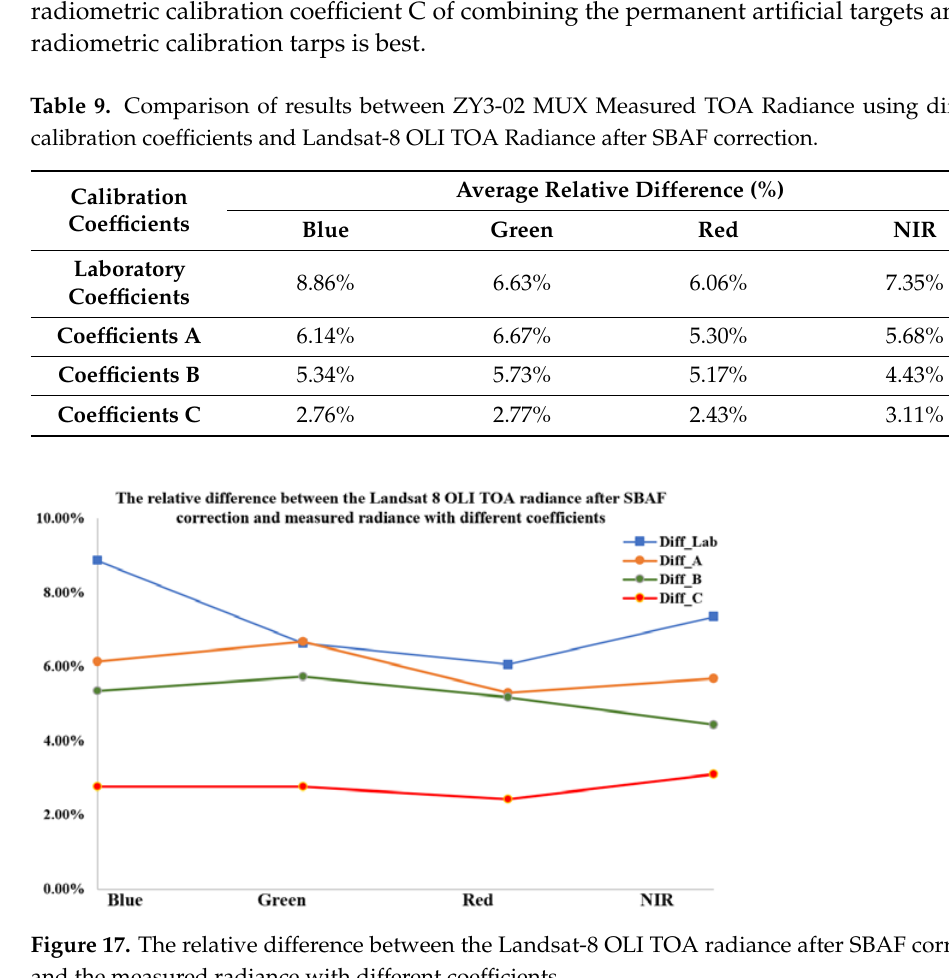
Table 8. Geometric conditions of ZY3-02 and Landsat-8 OLI for cross-calibration.